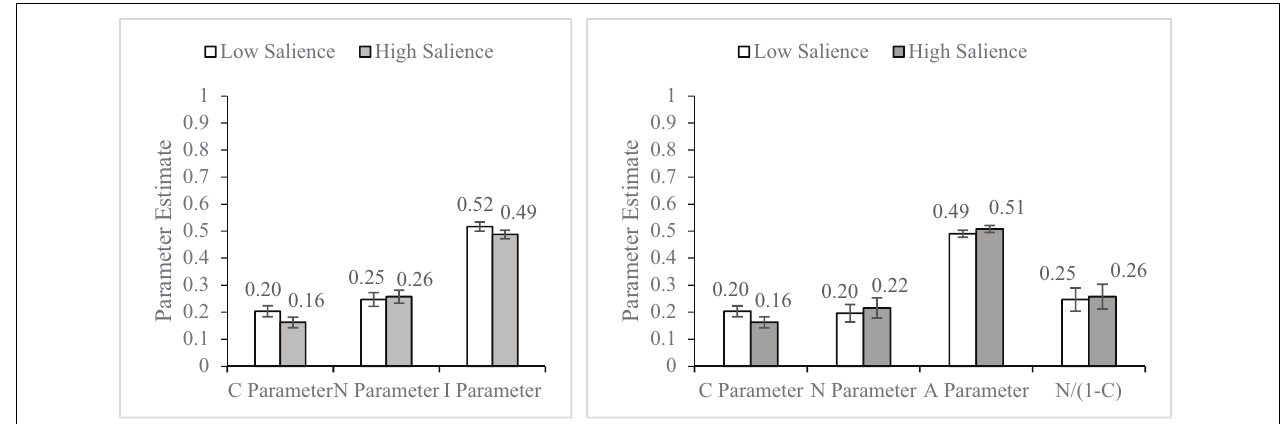
FIGURE A7 | Results of Study S1a by Gawronski et al. (2017) obtained from the CNI model (left) and CAN algorithm (right) . Error bars represent ± 1 SE.